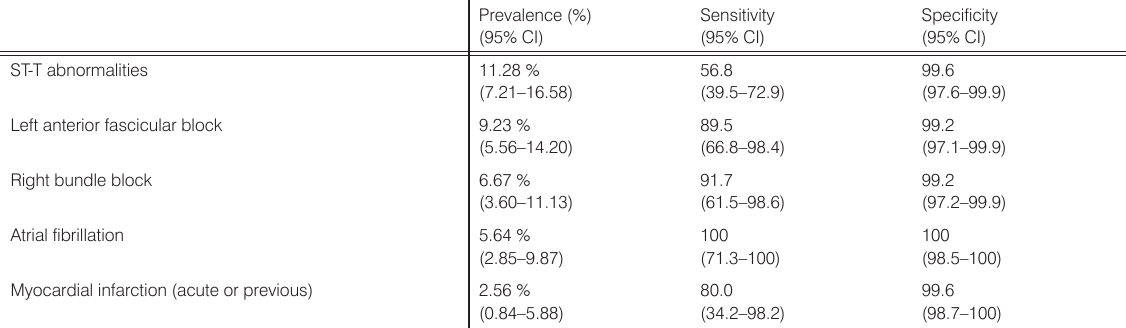
Table 3. Sensitivity and specificity of most prevalent ECG diagnosis of GP readings (95% CI: confidence interval of